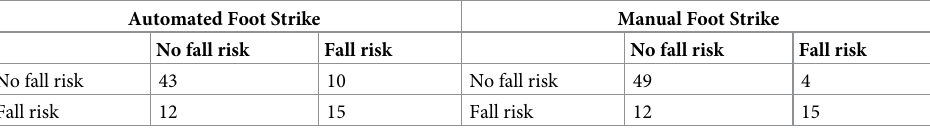
Table 3. Confusion matrices for automated and manual foot strike identification